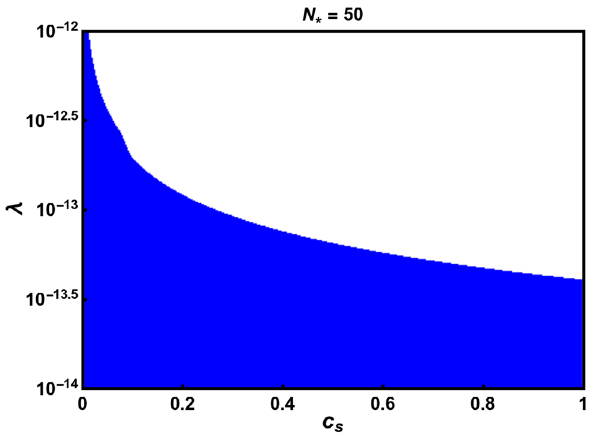
Fig. 5 The parameter space of λ − c s for which our warm DBI infla- tionarymodelwith N ∗ = 50iscompatiblewiththe68%CLjointregion of Planck 2015 TT, TE, EE + low P data [12] in r − n s plane